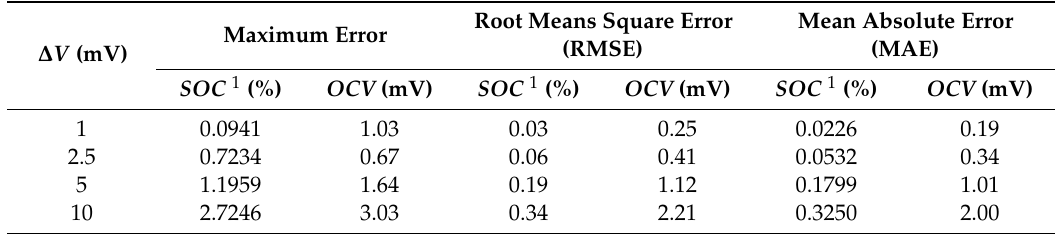
Table 7. Statistical error analysis at different values of voltage sensors.